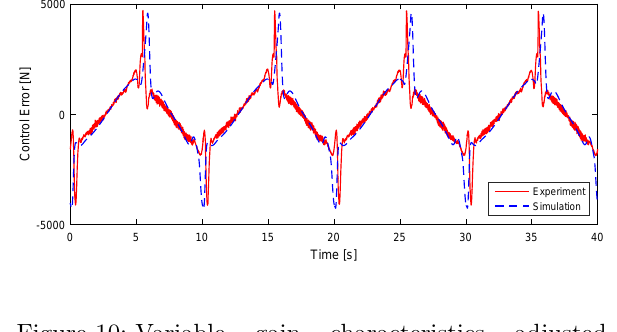
Figure 10: Variable gain characteristics adjusted further.